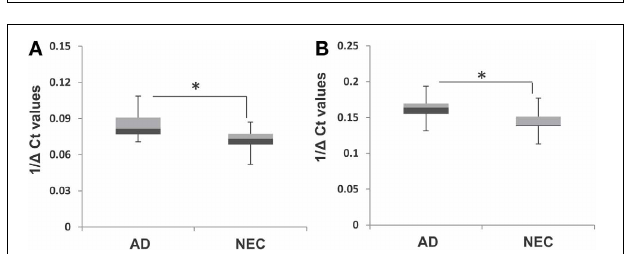
FIGURE 6 | Relationship between expression levels of miR-34c and miR-34a in plasma with Mini-Mental Status Examination (MMSE) scores in selected samples of age-matched groups. (A) Plasma expression levels of miR-34c represented by inverse (cid:2) Ct, plotted against corresponding MMSE scores. A high Pearson correlation coefficient value of − 0.72 indicates a strong correlation between MMSE scores and 1/deltaCt values, P < 0 . 0001. (B) Expression levels of miR-34a in plasma of AD and NEC individuals represented by inverse (cid:2) Ct, plotted against corresponding MMSE scores. A low Pearson correlation coefficient value of − 0.34 indicates a weak correlation between the MMSE scores and 1/deltaCt values, P = 0 . 012. Data points of Mini-Mental Status Examination (MMSE) score are shown as follows: ( ) moderate AD (score 10–20), ( ) mild AD (score 21–24), and ( ) NEC (score 25–30).